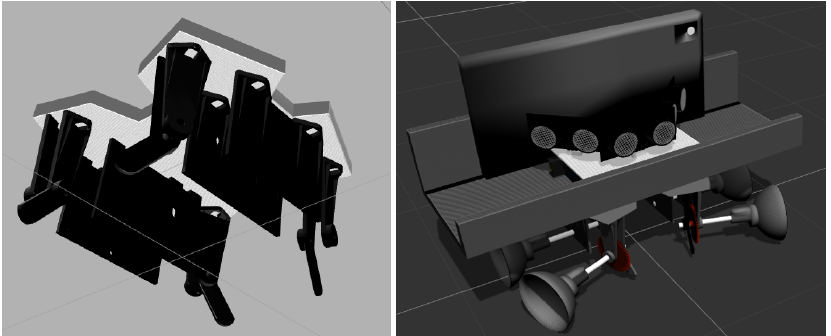
Figure 5. Andruino-R2 3D